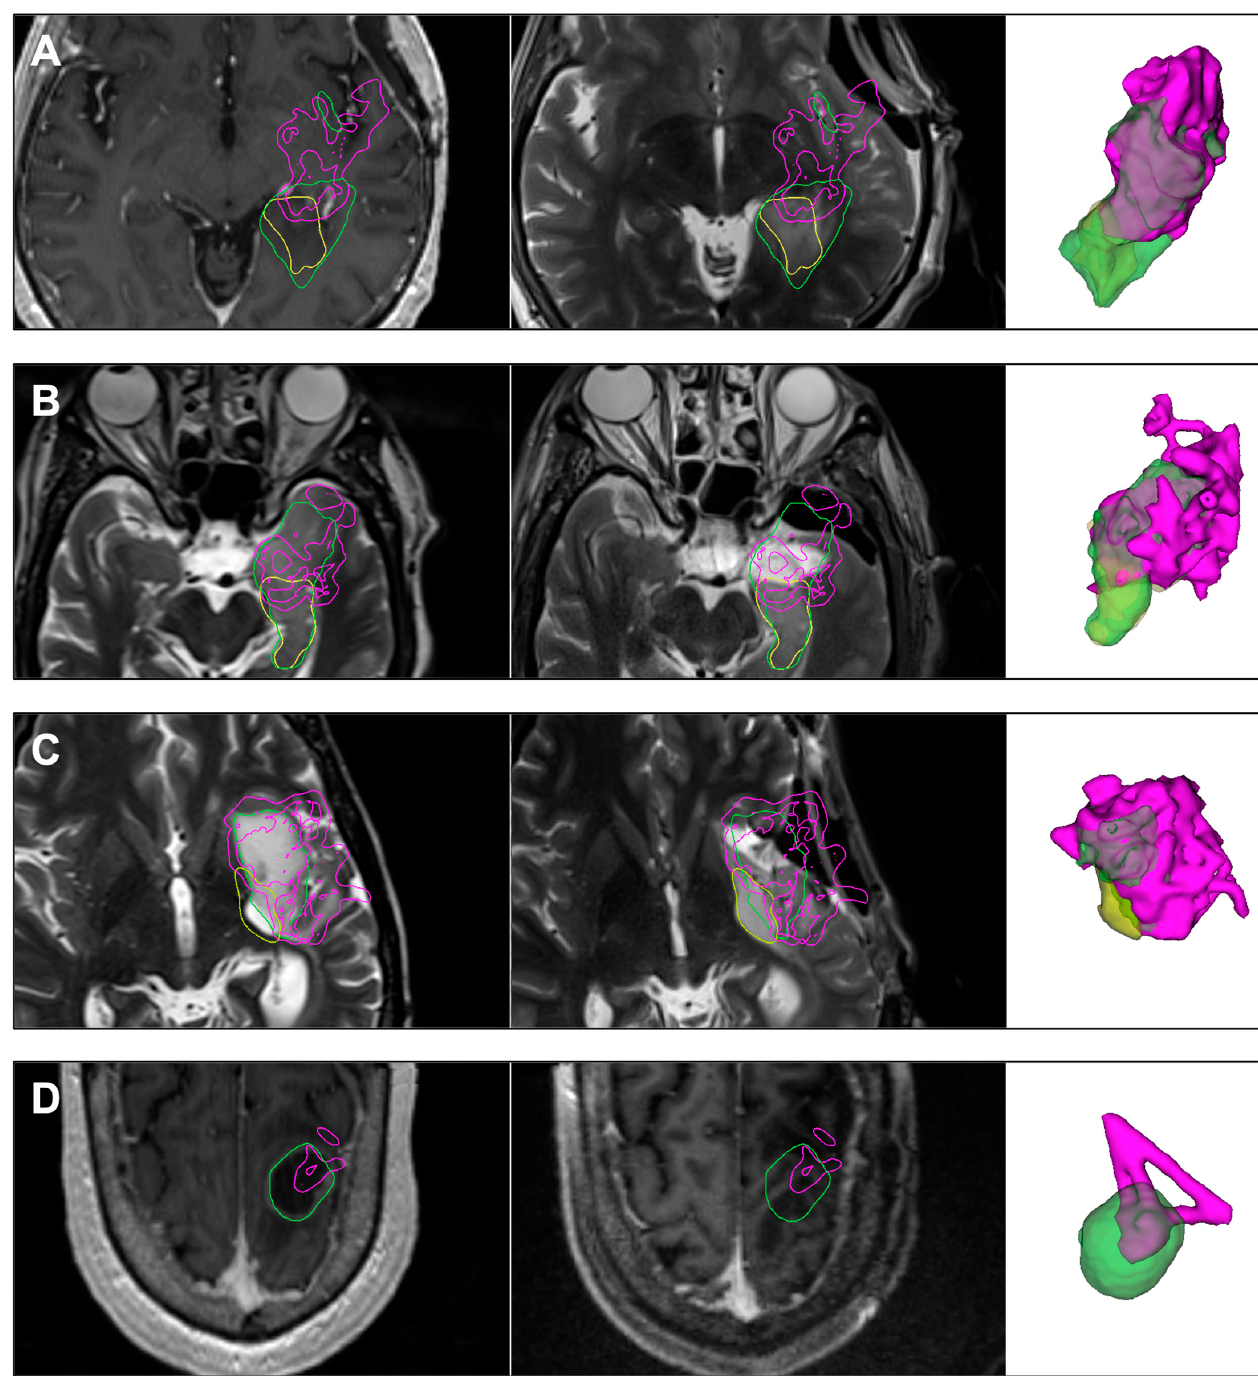
Figure 4. Select clinical cases. Each row shows, left to right, the preoperative MRI, intraoperative MRI, and 3D models of the tumor segmented on preoperative MRI (green), residual tumor segmented on intraoperative MRI (yellow), and the volume traced out by the tracked tool-tip positions of surgical instruments (pink). The contours of the models are also shown in the MRI images in their respective colors. In Panels A and B (Cases 12 and 36), the tracked resection cavity accurately represents the true resection cavity. In Panel C (Case 31), residual tumor volume estimation appears limited due to brain shift, but the residual location is accurate, nevertheless. In Panel D (Case 9), the tracked resection cavity does not cover the entire tumor even though there is no residual. This occurred because draining the large cystic component collapsed the resection cavity during surgery.